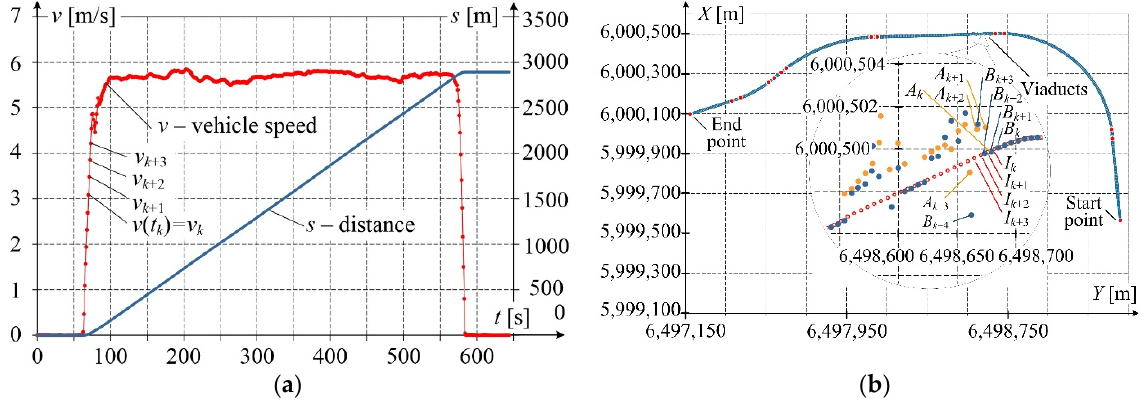
Figure 4. Results of measurement recorded in RTN mode: ( a ) speed changes and covered distance; ( b ) trajectory of railway line coordinates in PL-2000 reference system—where A k , B k , and I k are the coordinates recorded respectively by the receiver’s A , B , and INS at moments t k , t k+1 , ... with period 1 s, in the enlarged scale is shown a disturbance related to the passage under the road viaducts.